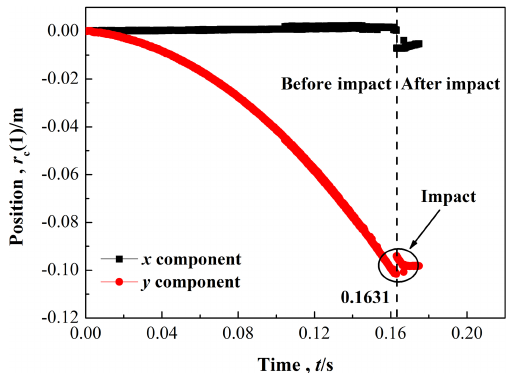
Figure 9. Position of the central point of marker 1 before and after the impact.